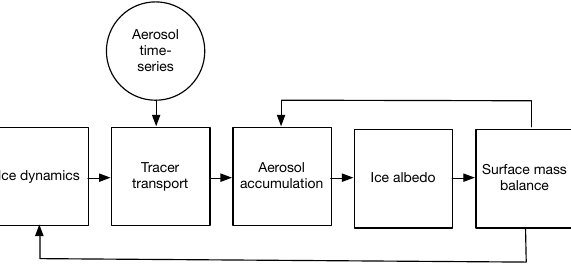
Figure 2. Model framework: the ice dynamics component delivers velocity and ice sheet dimensions to the tracer transport module. An aerosol time series in conjunction with the tracer transport conveys englacial aerosol concentrations to the accumulation module. The SMB module delivers snow depth and melt rates to the accumula- tion module, which calculates dust and BC amounts separately in the snowpack and on the ice surface. These results are then fed into the ice albedo module which is used by the SMB component (based on a simplified energy balance). The SMB is then fed back into the ice dynamics